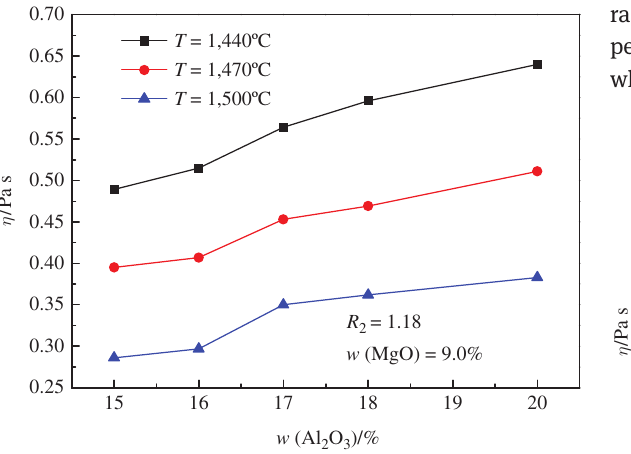
Figure 3: Effect of w (Al 2 O 3 ) on viscosity of slag.